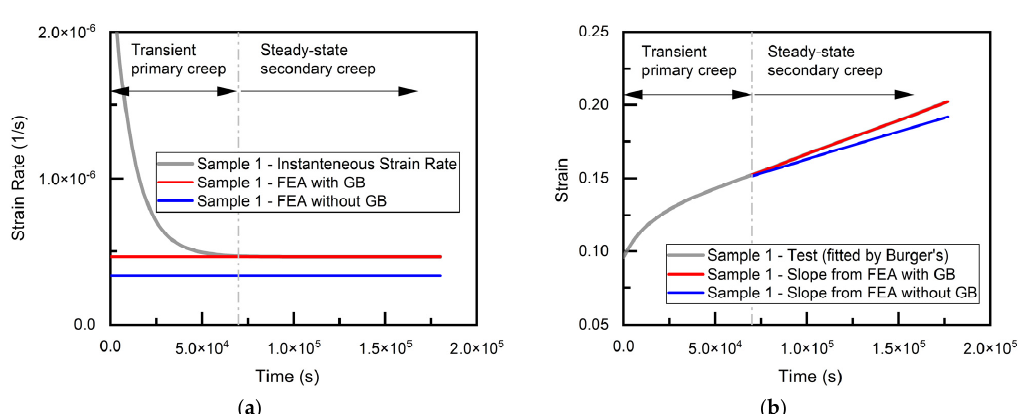
Figure 5. Simulation results of Sample 1 after calibration ( a ) strain rate ( b ) strain. The instantaneous strain rate was determined as the time derivative of the fitted model. The strains are plotted versus time in Figure 5b, according to the constant rates from the steady-state finite element simulations, and compared with the near steady-state region of the experimental data.